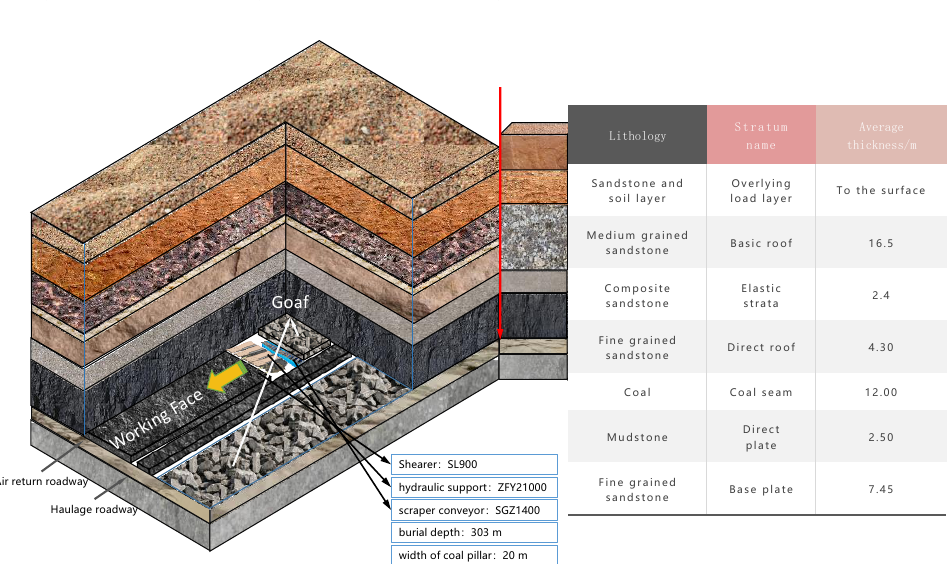
Figure 1. The relationship between the location of the mine field and the stope layout. The complexity of the structure is relatively simple. The average thickness of the 2-2 coal seam is 12.0 m, the strike longwall retreating mining method is adopted, the roof is managed by the total caving method, and a shield hydraulic support is used to support the roof of the stope. The direct roof of the 2-2 coal seam is fine-grained sandstone, followed by medium and fine sandstone with a thickness of about 4.3 m. The basic roof is 16.5 m medium-grained sandstone. The floor is dominated by siltstone, followed by mudstone with a thickness of about 2.5 m. The dip length of the working face is 303 m. At present, a 20 m wide coal pillar is reserved in this section. The roadway layout plan and the geological histogram of the working face are shown in Figure 2.